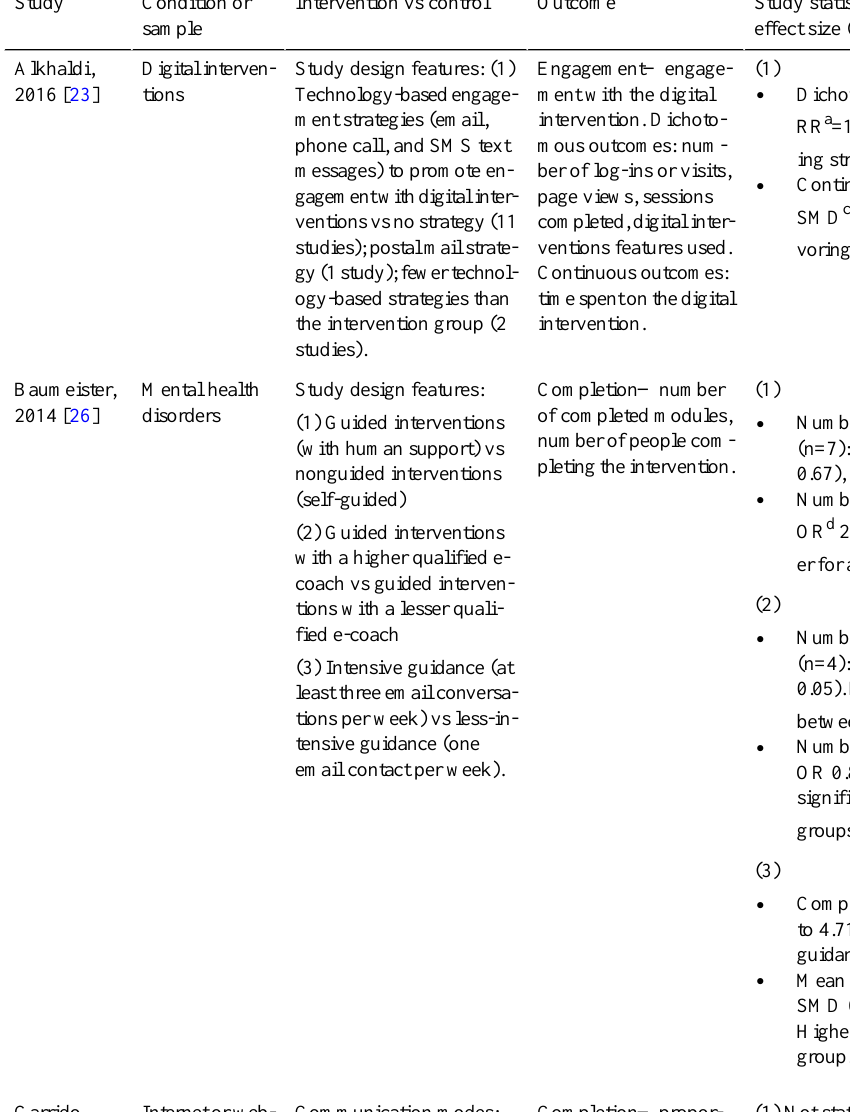
ResultsStudy statistics: number of